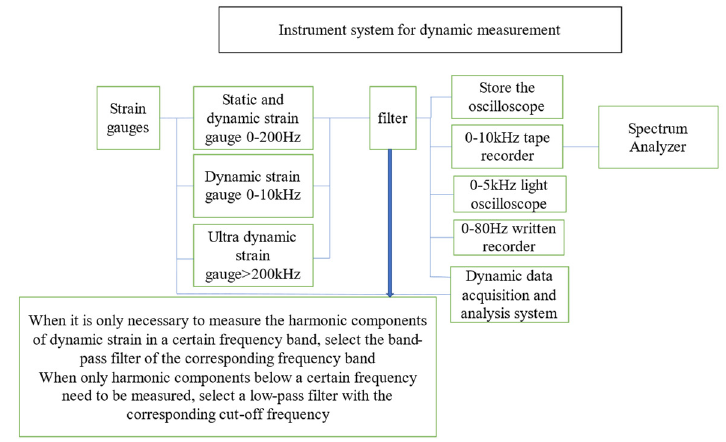
Figure 3. Instrumental system diagram for dynamic measurement.